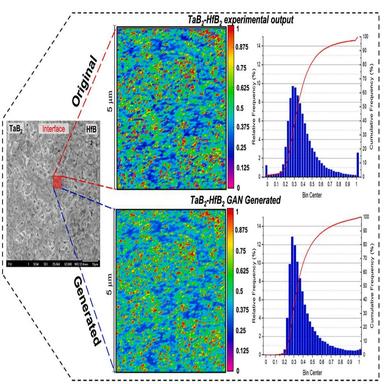
TaB2 - HfB2 joined ceramic normalized elastic modulus mapping graphical representation and comparison of frequency and cumulative distribution of original recording (Top) and GANs Re-generated datasets (Bottom).